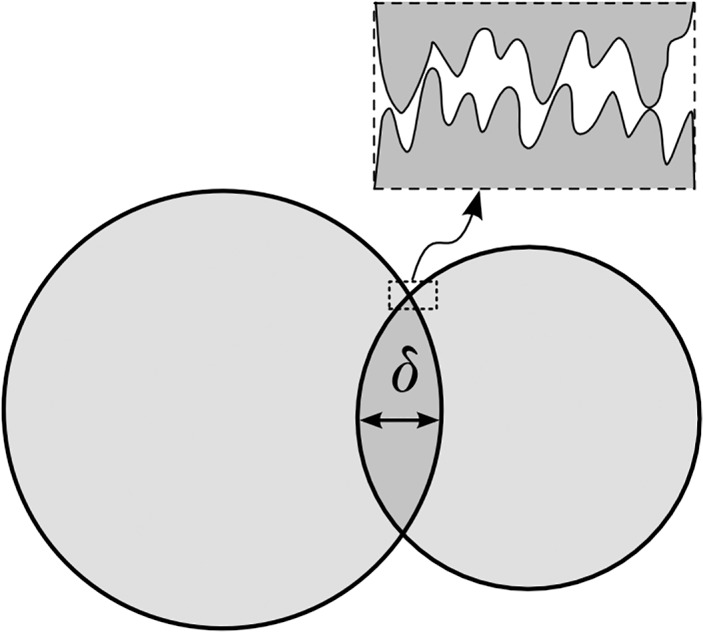
Contact between two DEM particles.